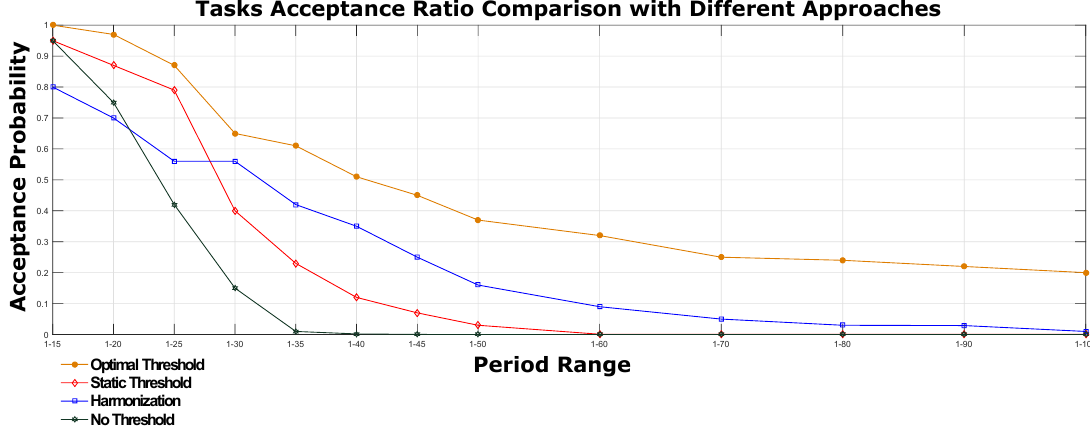
Figure 11. Tasks Acceptance Ratio using various A=approaches for an increasing number of tasks.